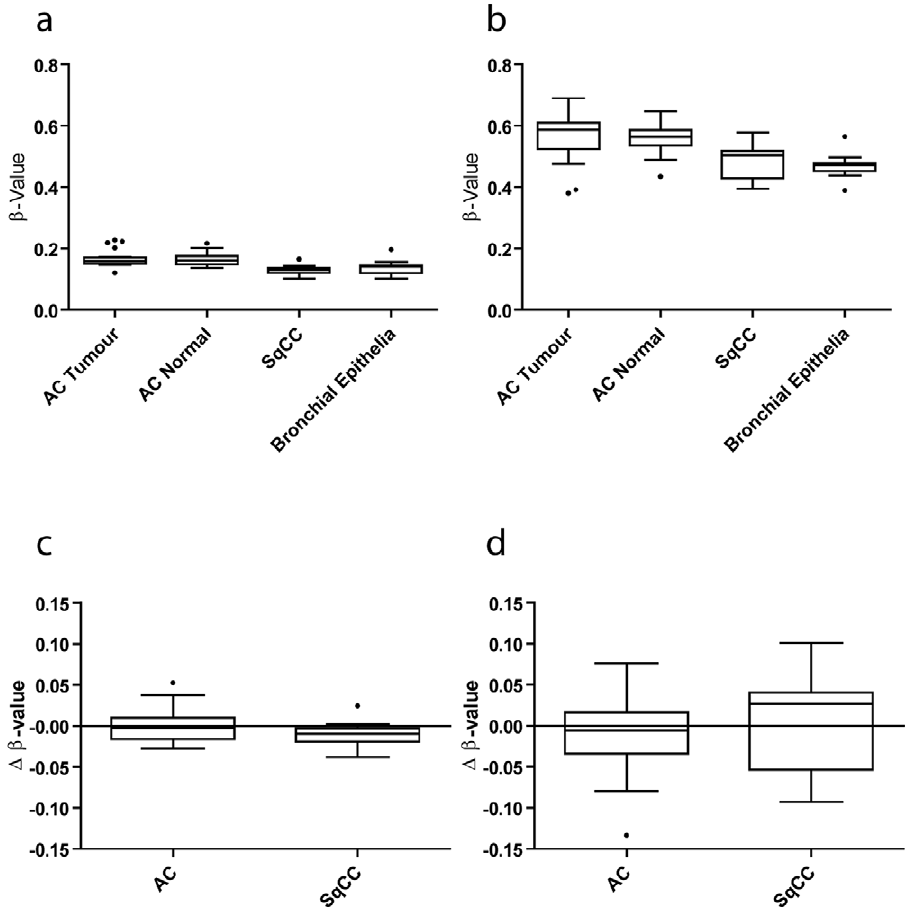
Figure 4. Global DNA methylation patterns of NSCLC tumors and associated normal tissues. Comparison of average DNA methylation levels between AC tumor, AC normal (histologically normal lung parenchyma), SqCC tumor, and bronchial epithelia. a) CpG island probe averages. The average of each of the profiles at probes located within CpG islands is plotted as a component within the box plot. In this panel, SqCC and bronchial epithelia samples appear to have slightly lower DNA methylation levels than the AC tumor and AC normal groups. b) Non-CpG island probe averages. The average of each of the profiles at probes not located within CpG islands is plotted as a component within the box plot. In this figure b - value is the level of methylation as defined by the methylated signal/total signal for each probe. In this panel, SqCC and bronchial epithelia are significantly lower in methylation level compared to the AC tumor or AC normal groups, indicating that outside of CpG islands, where the bulk of genomic methylation occurs, the central airway samples are more hypomethylated. c) Average differential methylation levels at CpG islands. The average differential is plotted for the 30 AC samples and the 13 SqCC samples. The two groups are very similar in their differential profile within CpG island probes. d) Average differential methylation levels at CpG sites not located within CpG islands. In this plot the average differential methylation level is plotted for probes that are not located within CpG islands. Again, the two groups are not significantly different by a Mann-Whitney U test.